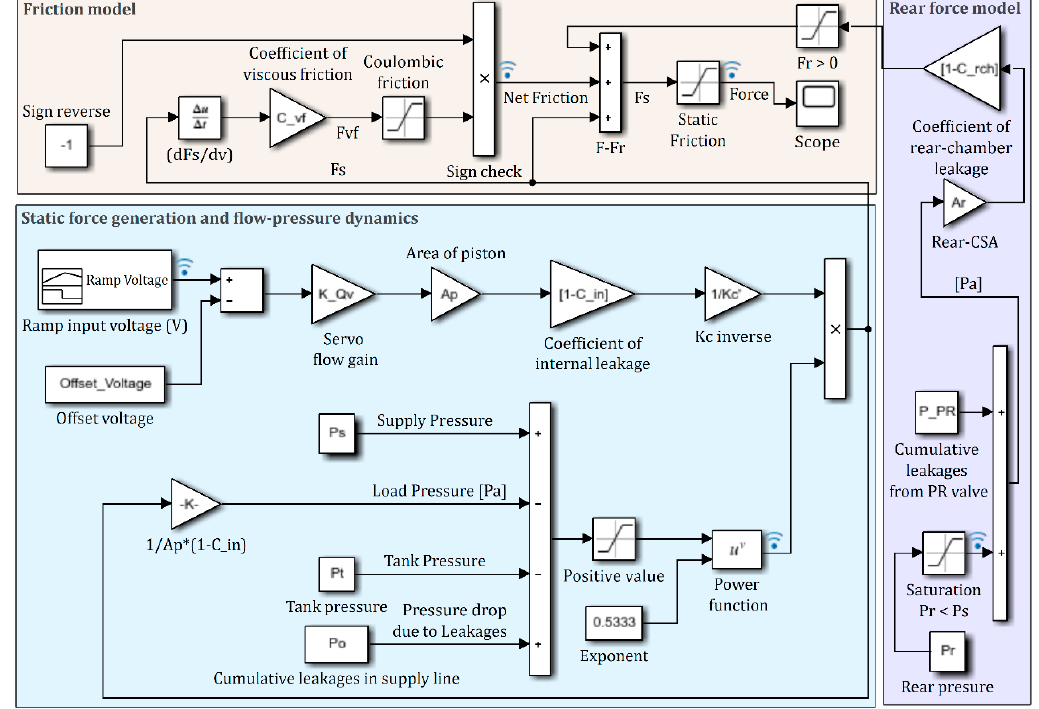
Figure 15. Simulink block diagram of the cumulative nonlinear static force model of the actuator with flow controlled with servo valve and pressurized flow supplied to the rear chamber.